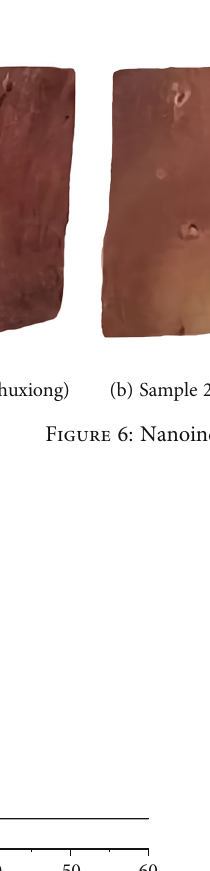
Figure 5: Diagram of representative mudstone samples.